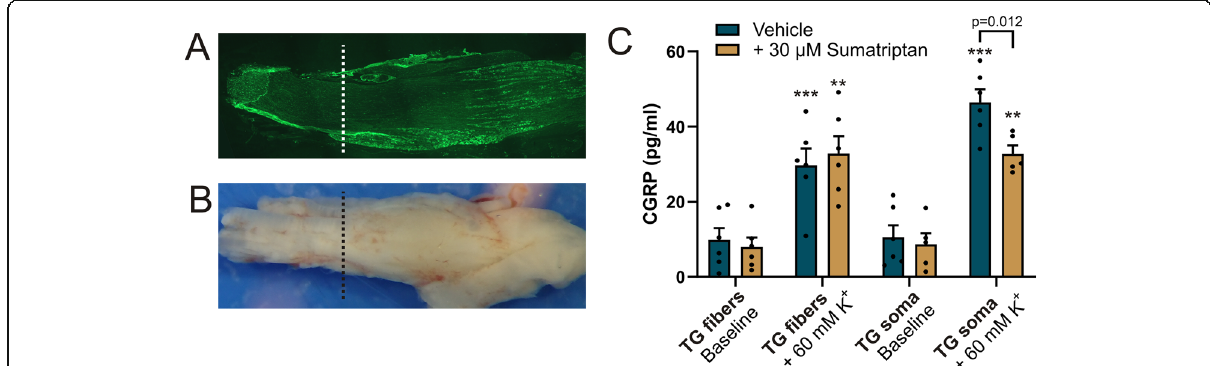
Fig. 1 CGRP release in vitro from two different regions isolated from the TG. The soma are located in the center of the TG ( a ). b The TG was cut into one area that which is fiber-rich and devoid of neuronal cell bodies ( “ TG fibers ” ) and the other that was rich in neuronal somas ( “ TG soma ” ). CGRP was increased significantly from baseline in all samples stimulated with 60 mM K + (** p > 0.01, *** p < 0.001, paired student ’ s T-test). Sumatriptan significantly inhibited the CGRP release only from the from TG containing soma. Data is expressed as mean ± SEM, n = 6 for vehicle, n = 5 for sumatriptan